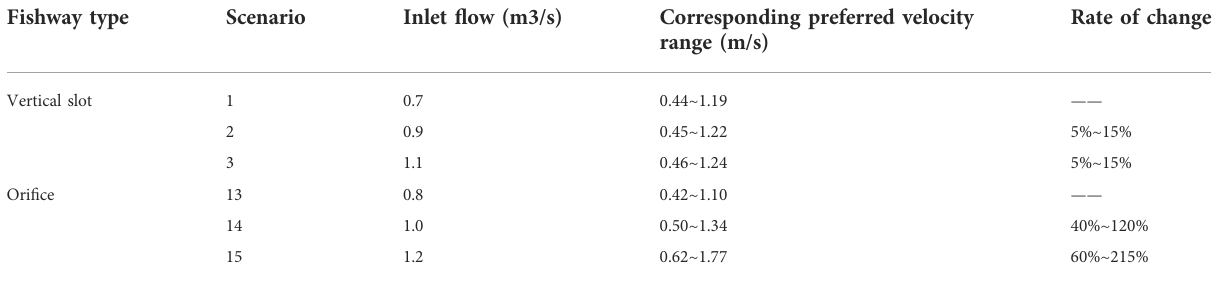
TABLE 9 Comparison of velocity variations with fl ow